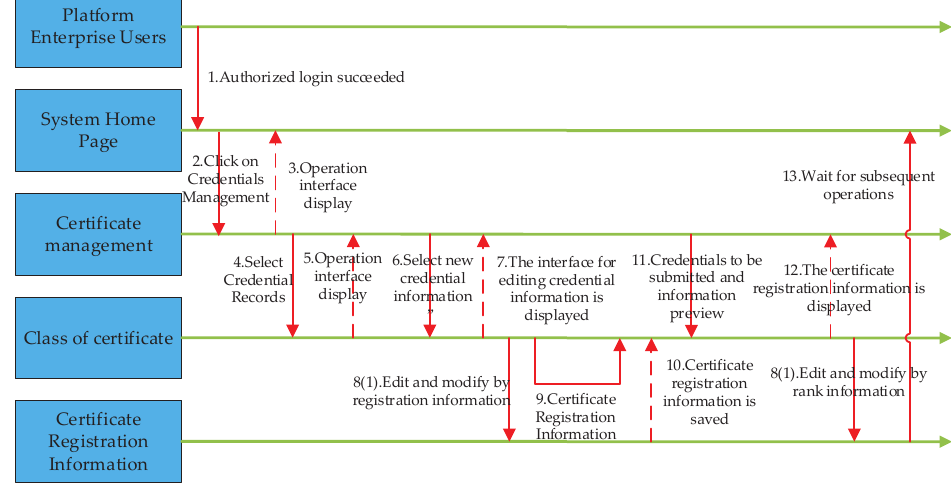
Figure 4. Schedule diagram of the certificate registration